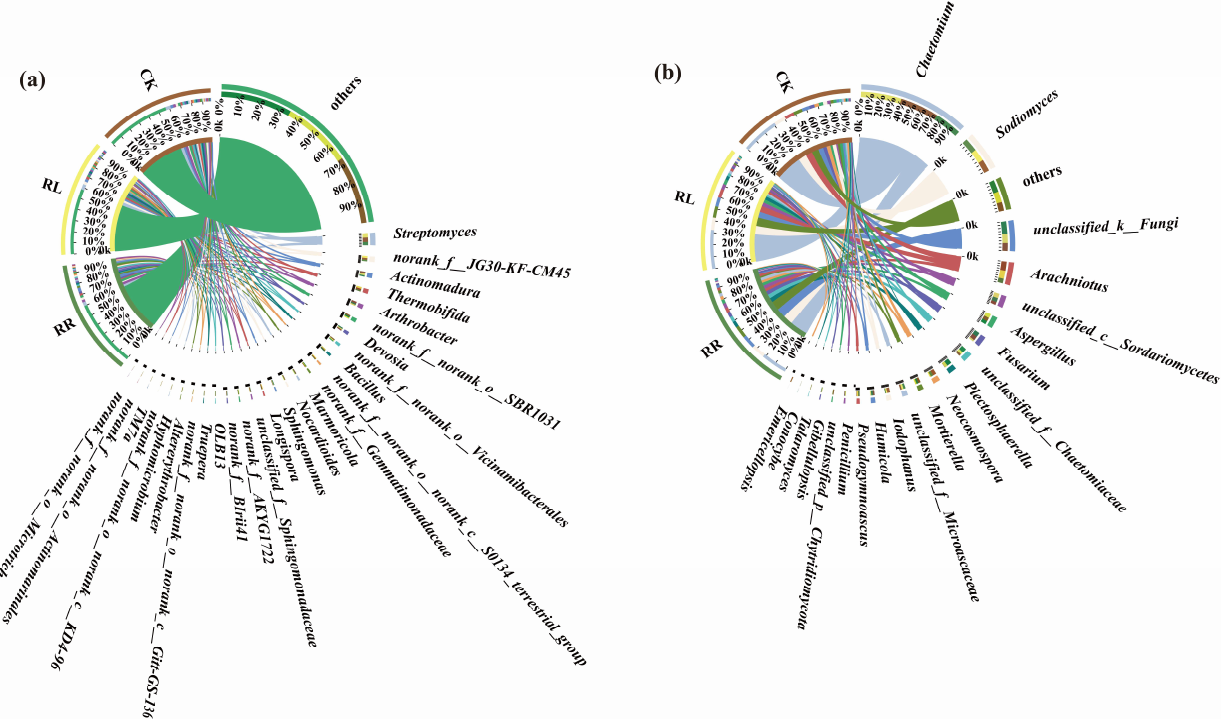
Figure 4. Proportions of the dominant soil bacterial ( a ) and fungal ( b ) genera in the oilseed rape rhizospheres in the monoculture system (RR), intercropping system (RL) and